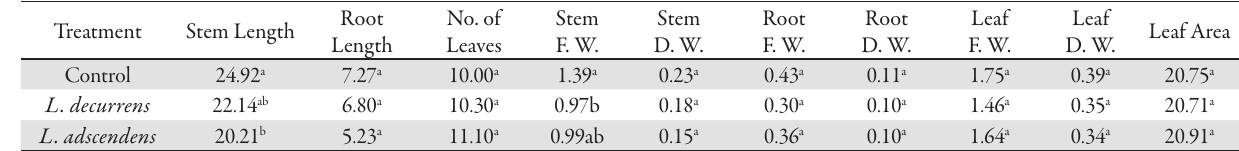
Tab. 5. Effect of Ludwigia decurrens and L. adscendens exudates on vegetative parameters of Corchorus olitorious at week 7 Treatment